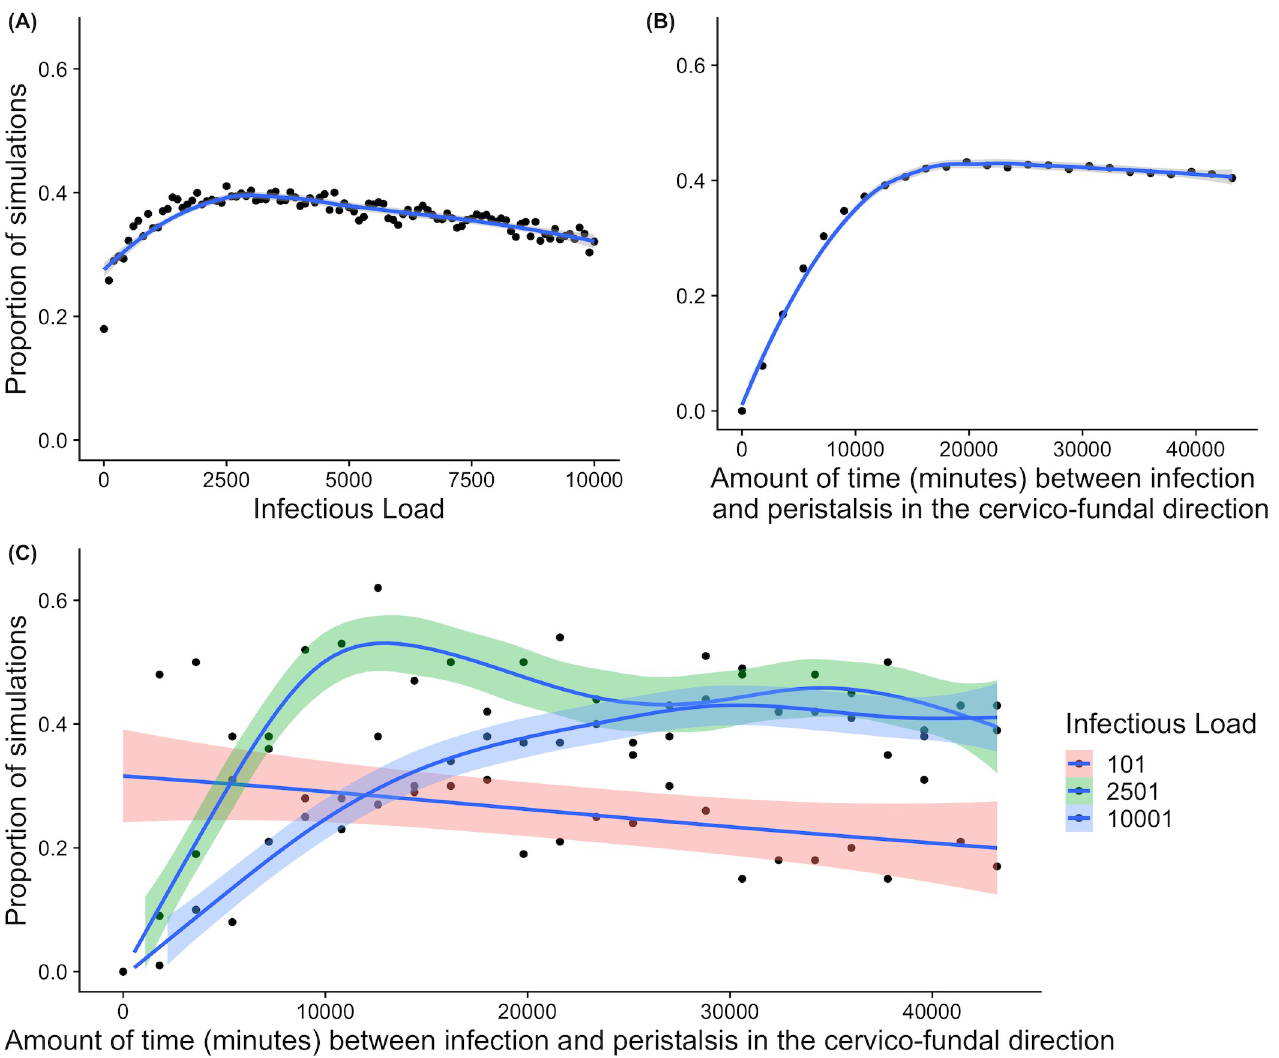
Fig 6. Graphical summary of the proportions of simulations where ascension occurred and role of load (A), peristalsis (B), and both (C) . (A) Simulations analysing the impact of infectious load (the count of initial bacteria) on the the chances of ascension. (B) The time (in minutes) prior to the onset of peristaltic contractions in the cervico-fundal direction and chances of ascension. (C) The relationship between infectious load, timing of infection with respect to peristaltic contractions, and the chances of ascension. Each figure shows the proportion of simulations from the model where the infection ascended (proportion of representations from 252, 500 simulations) on the y axis, where the x axis represents the factor being modified (A. infectious load, B. peristalsis, C. peristalsis and grouped by infectious load). These are simulated over a range of infectious loads (10 simulations at each value of infectious load from 1 to 10001 in steps of 100. The blue lines represent a loess regression against the proportion of simulations resulting in ascension, and the shaded regions are 95% confidence intervals of the regression. Dots represent simulations at a particular parameter value.